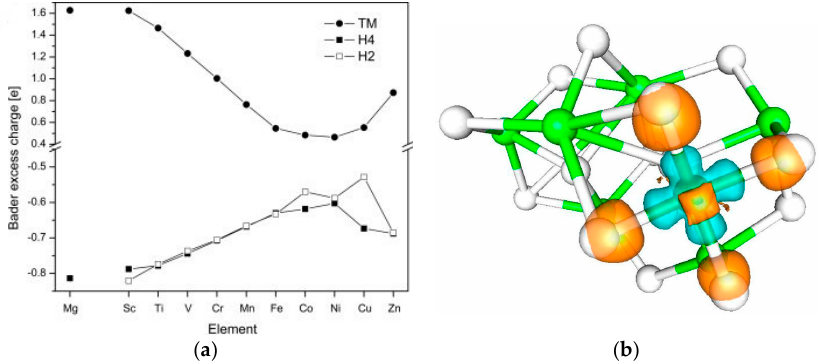
Figure 4. ( a ) Bader excess charge on transition metal (TM) dopants and on nearest neighbor H atoms for the entire MgH 2 :TM 3d series (the value for pure MgH 2 is shown on the left). Reprinted with permission from Ref. [38]. Copyright 2014 Hydrogen Energy Publications, LLC; ( b ) Charge density difference of Ni-doped (MgH 2 ) 7 cluster, orange denoting charge density depletion and blue accumulation. In agreement with ( a ), electronic charge is transferred from H − ion to d-state of the Ni dopant. Reprinted with permission from [29]. Copyright 2013 American Chemical Society. As shown in Figure 5, the difference between the enthalpies of reactions (13) and (1) is given by the enthalpy of alloy formation (δ∆H (cid:2868) ) (cid:3028)(cid:3039) . The reader interested in thermodynamic tuning of hydride